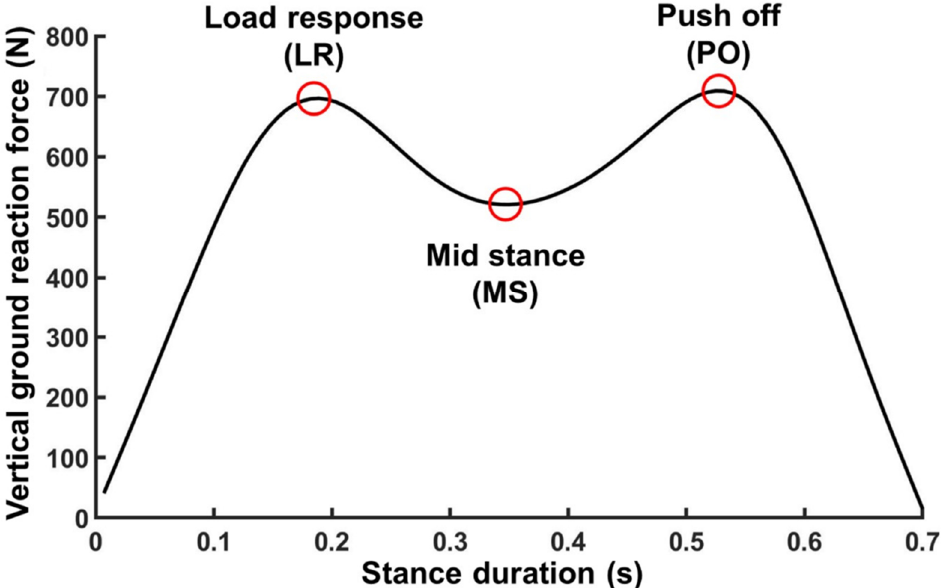
Figure 1. An illustration of the VGRF curve for a single step. The red circles denote three stereotypical time points for each step; the time point of load response (LR), mid stance (MS), and push off (PO). The LR and PO are the time points of two peaks of the double bump pattern of the VGRF curve, and MS is the time point of the minimal value of VGRF between LR and PO.